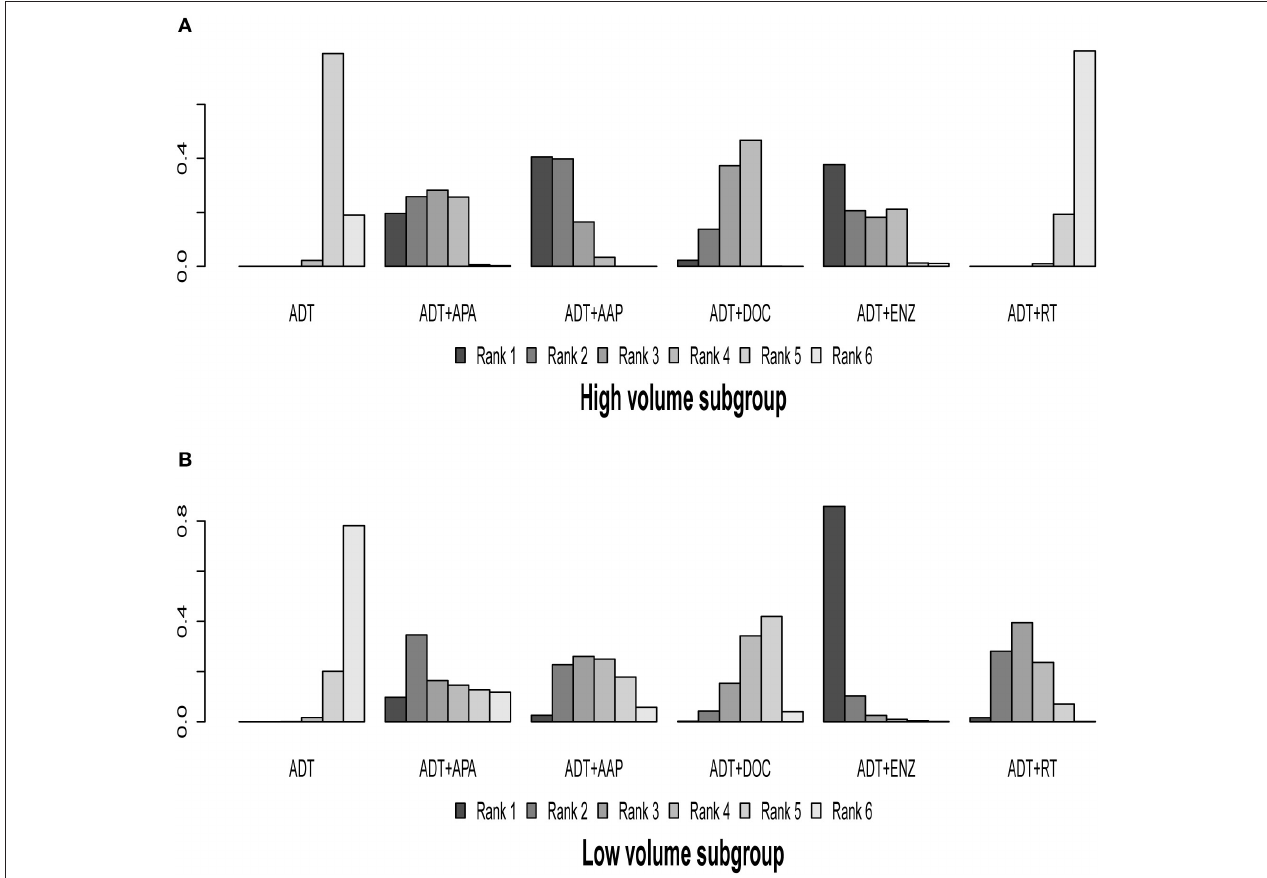
FIGURE 6 | Ranking plot based on the probabilities of interventions in patients with different disease volume: (A) High-volume subgroup; (B) Low-volume subgroup. The height of every column refers to the probabilities of the rank. The actual outcome being measured in this figure was overall